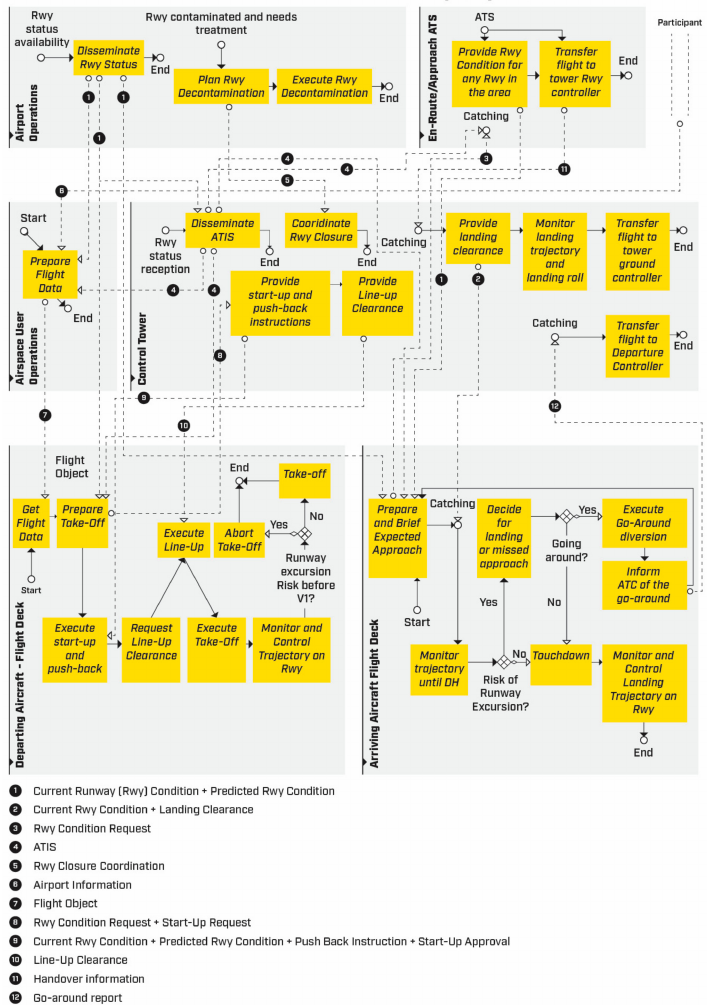
Figure A2. The new conceptual method for dissemination and utilization of the runway surface condition status based on the outputs of SESAR Pj03b-06 Solution.